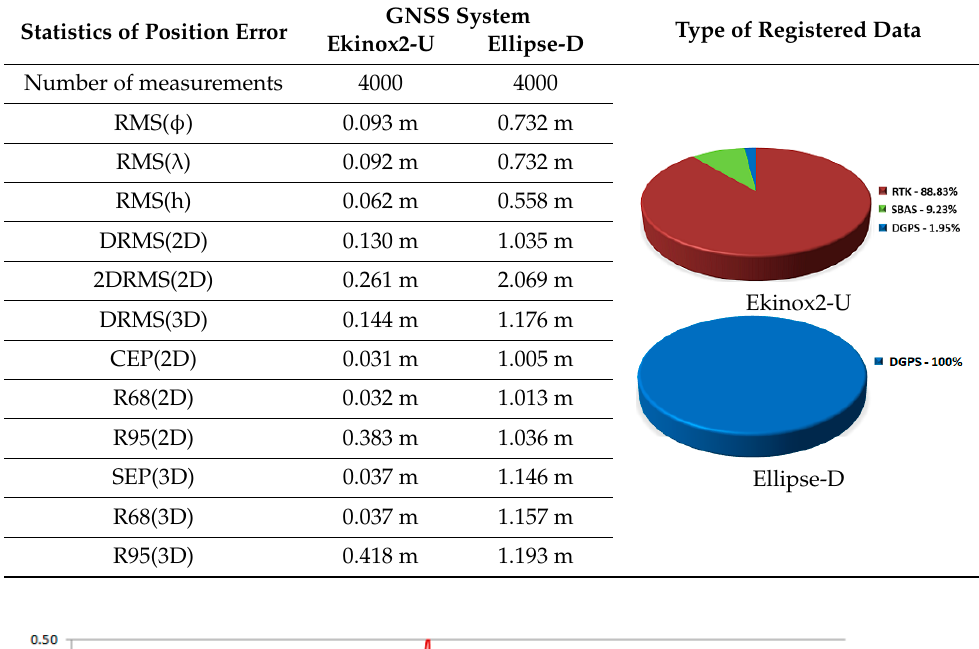
Table 2. The position accuracy measures of the GNSS/INS systems, models Ekinox2-U and Ellipse-D, during the hydrographic surveys on route no. 1.